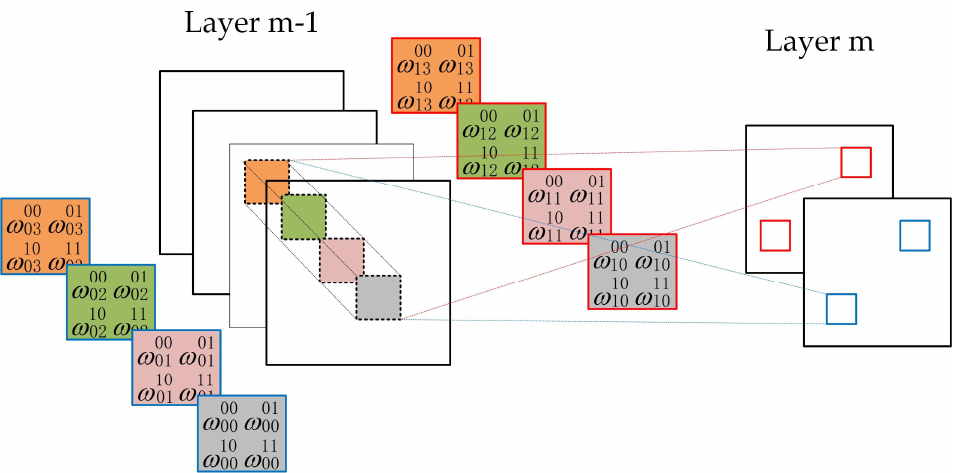
Figure 3. Example of a convolutional layer. Pixels in layer m (blue or red squares) are computed from pixels of layer m − 1 that fall within their 2 × 2 receptive field in the layer below (shown as colored rectangles). Weight matrices for feature maps in layer m are listed in the squares with the same color.